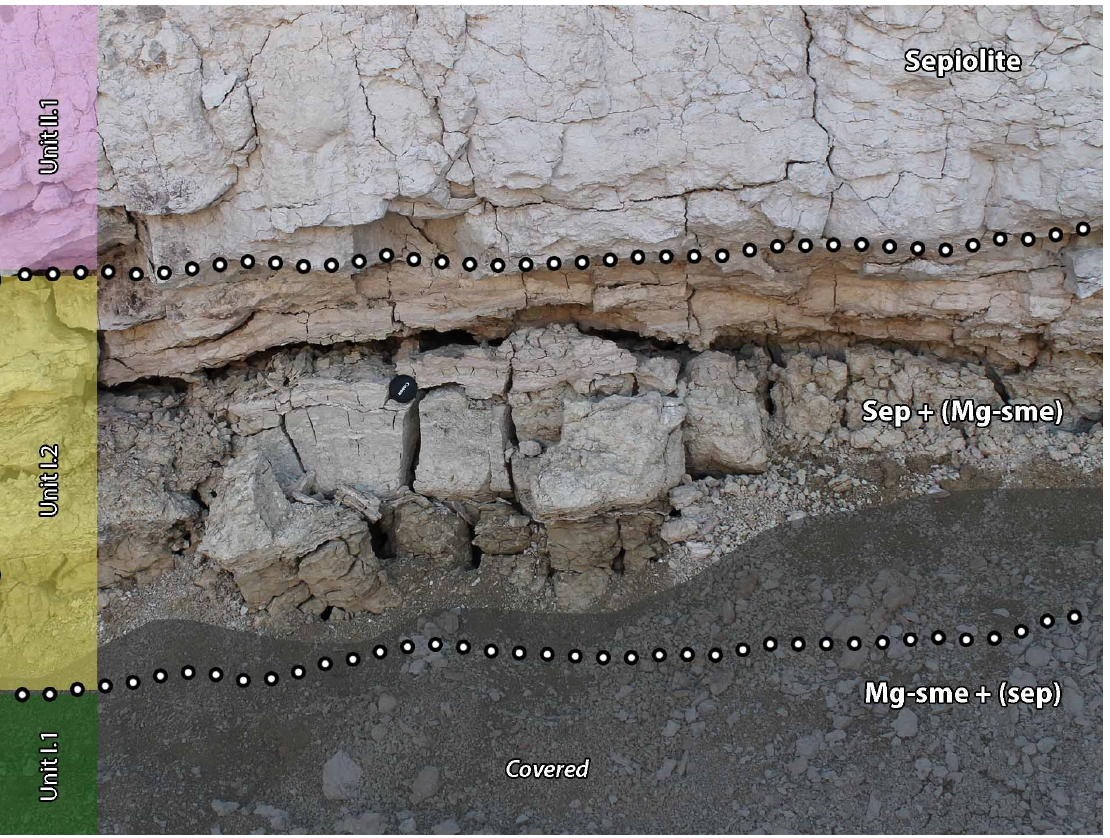
Figure 3. Outcrop view of representative lithological section (BS2I) showing the boundaries among the different units established.